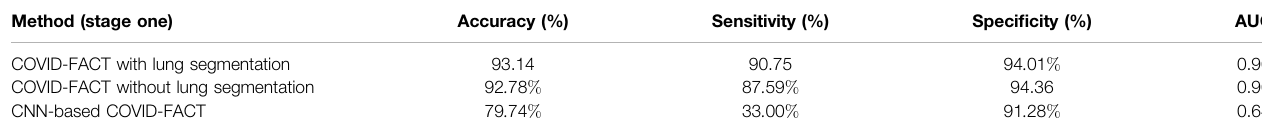
TABLE 4 | The performance of stage one in diagnosis of slices demonstrating infection.